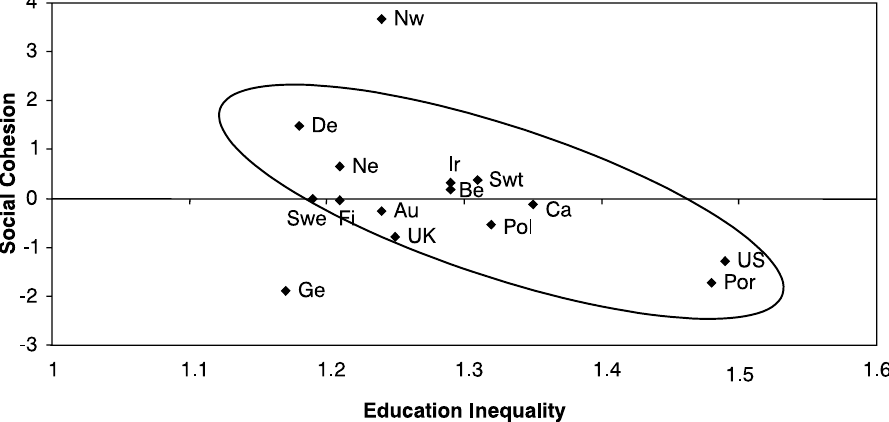
Figure 1. Relationship between social cohesion and education